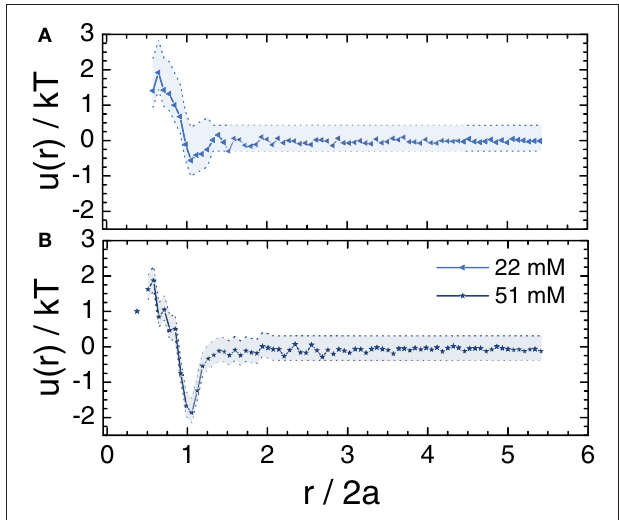
FIGURE 2 | Interaction energy normalized by kT , u ( r ) / kT , as a function of normalized radial distance r / 2 a . The u ( r ) was calculated from the measured radial distribution function at a volume fraction of φ ≈ 0.01 in 80 (w/w)% glycerol in water with (A) 22 mM and (B) 51 mM NaCl. The shaded areas indicate representative error